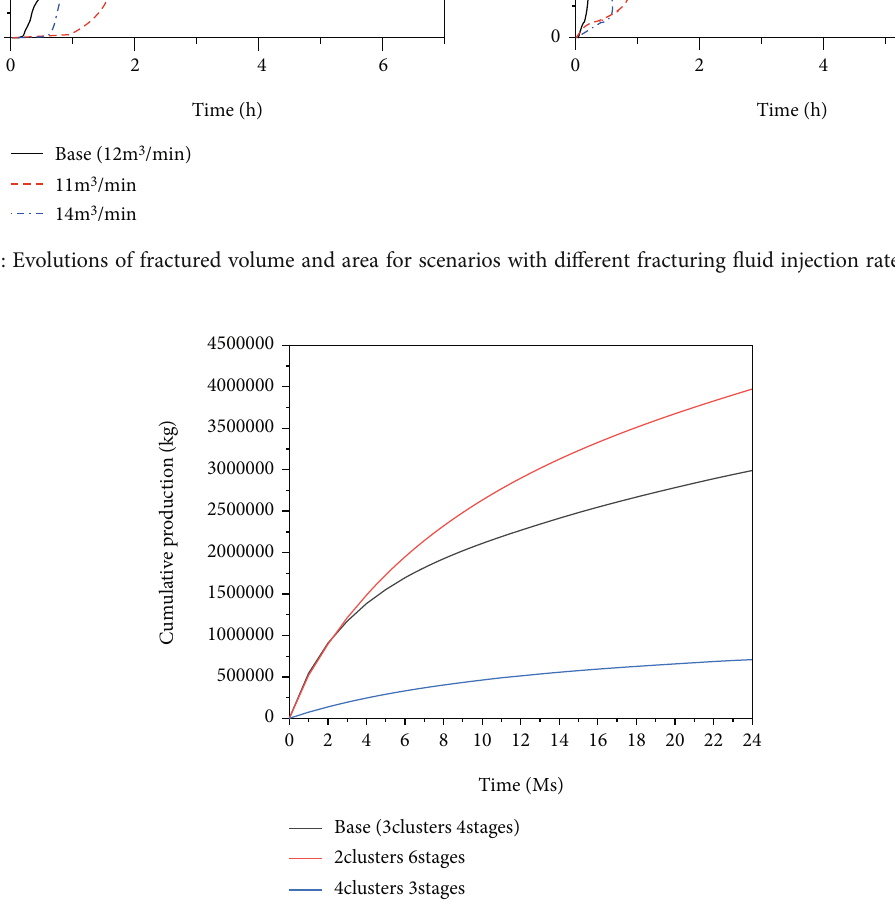
Figure 10: Cumulative oil production from horizontal wells with di ff erent stage and cluster